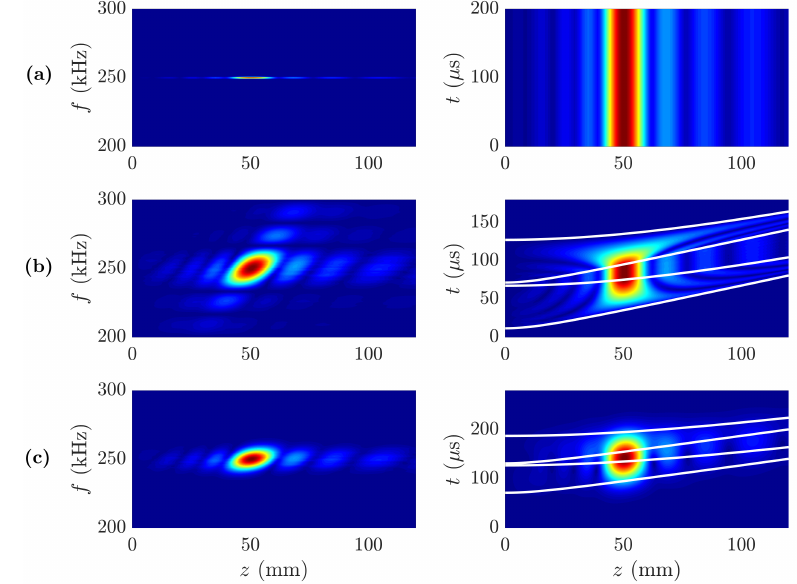
Figure 3. Longitudinal focusing profile spectra | P ( z , f ) | (left) and transient focusing profile | P ( z , t ) | (right): ( a ) Continuous Wave, ( b ) Modulated Rectangular Pulse, and ( c ) Modulated Gaussian